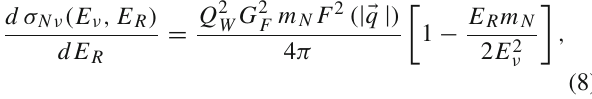
Fig. 1 The integrated neutrino flux originating from galactic (dashed lines) and extra-galactic (solid lines) components for different DM masses m X as a function of DM lifetime. The flux has the general 1 / m X scaling, is inversely proportional to progenitor lifetime for τ X (cid:2) t 0 and the extragalactic component asymptotes to a constant in the converse limit. The maximum DR flux as the sum of solid and dashed lines is obtained for τ ∼ t